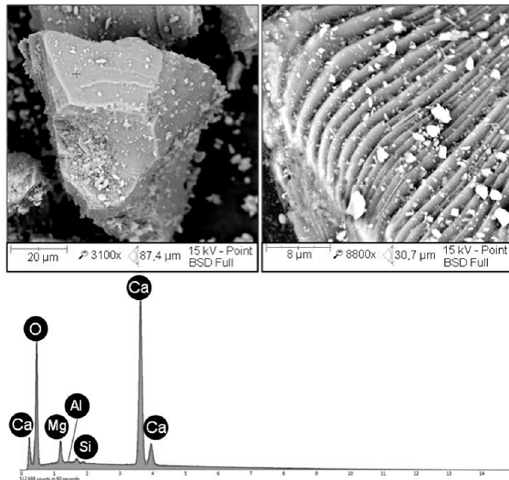
Figure 4. MEV backscattered electron images and EDS of marble waste.